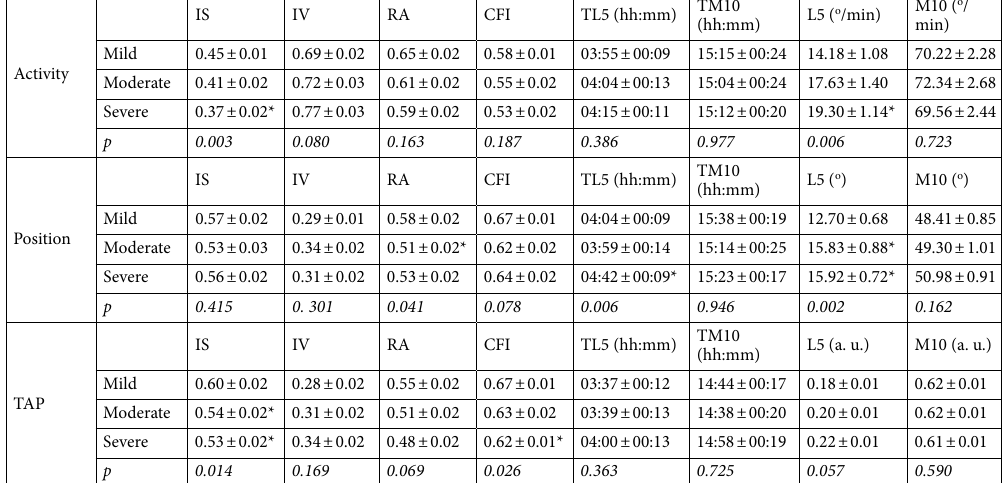
Table 2. Non-parametrical analysis of the circadian patterns for activity, position and TAP according to SDB severity. Snorer/Mild: subjects with AHI lower than 15 (n: 31); Moderate: AHI higher than 15 and lower than 30 (n: 19); Severe: AHI higher than 30 (n: 28). Interdaily stability (IS); intradaily variability (IV); relative amplitude (RA); circadian function index (CFI); mean of the 10 consecutive hours with the highest values (M10) and its timing (TM10); mean of the 5 consecutive hours with the lowest values (L5) and its timing (TL5). Values are expressed as the mean ± SEM. p denotes global significance level according to General Linear Model (in bold probability values lower than 0.05). * Indicates statistical differences when compared to mild SDB patients (General Linear Model controlled for gender, age and BMI followed by a Bonferroni’s post hoc, p < 0.05).